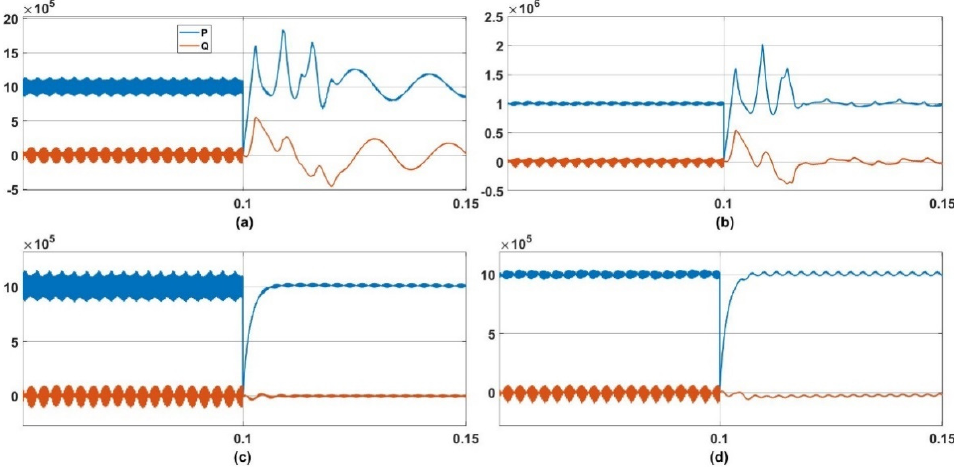
Figure 28. Power flow in symmetrical fault in the case of ( a ) 2L- αβ , ( b )3L- αβ , ( c ) 2L-dq and ( d ) 3L- dq.